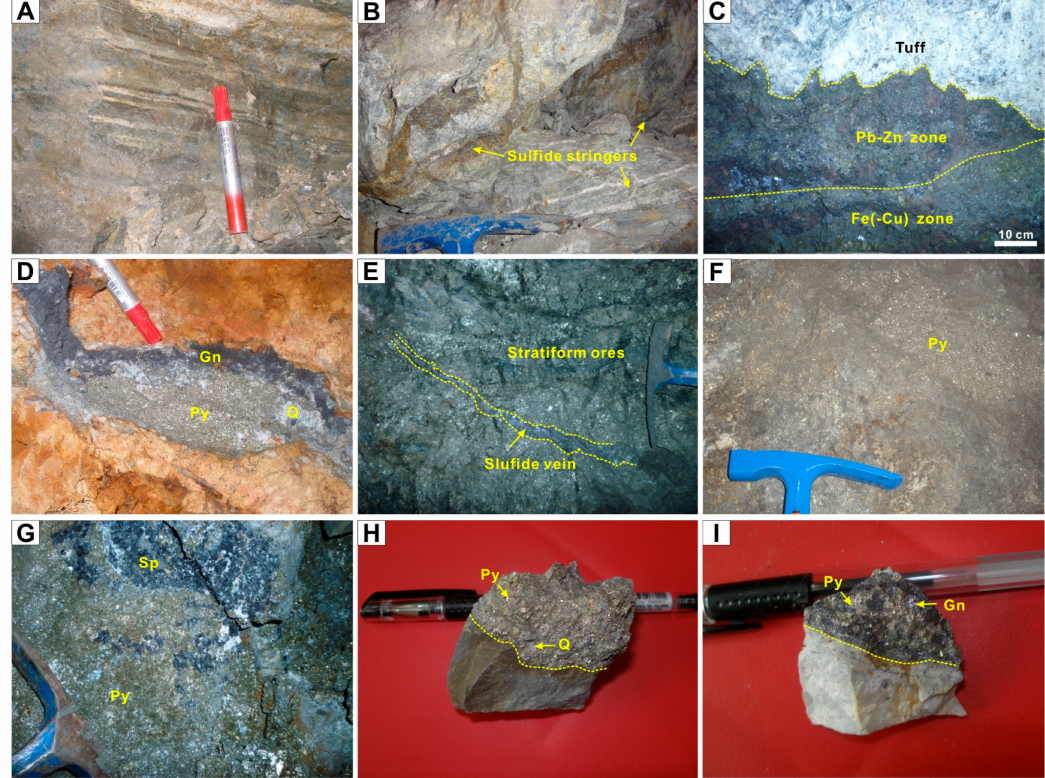
Figure 5. Photographs showing occurrences and texture of the stratabound ores at Laochang deposit. ( A ) Banded sulfide ore in 1650 m mining tunnel. ( B ) Tuff in 1700 mining tunnel crosscuts by vein and veinlet sulfide ore. ( C ) The metal zonation from top to bottom: Pb-Zn ore to Fe-(Cu) ore from stratabound ores 1700 level. ( D ) Pyrite-sphalerite-galena vein filling in the fracture of tuff in 1650 m mining tunnel. ( E ) Galena-calcite vein crosscuts the stratiform ore in 1700 mining tunnel. ( F ) Massive coarse-pyrite ore in 1700 mining tunnel. ( G ) Massive sulfide ore composed of pyrite, sphalerite and minor chalcopyrite. ( H ) The clear contact boundaries between the tuff and massive sulfide ore from 1650 mining tunnel. ( I ) The clear contact boundaries between the dolomite and massive sulfide ore in 1750 mining tunnel. Mineral abbreviations: Q = quartz, Py = pyrite, Sp = sphalerite, Gn =